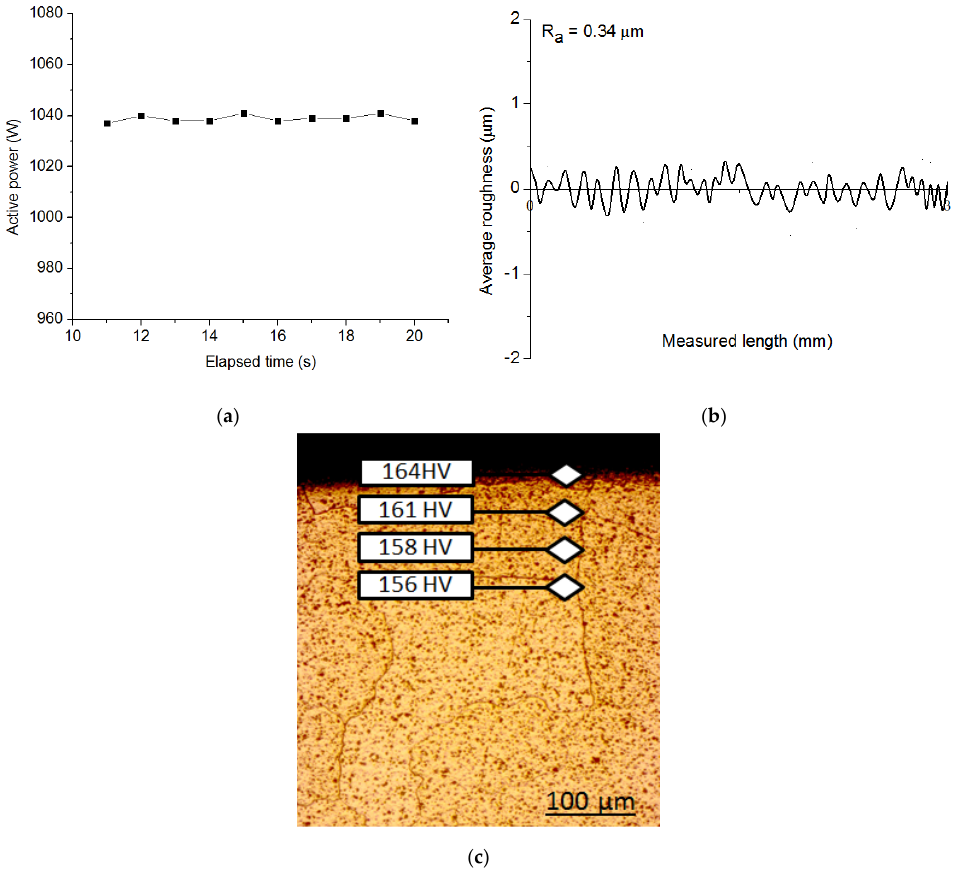
Figure 4. Representative values of the technical performances at the experimental No. 13: ( a ) Power consumed, ( b ) average roughness, ( c ) Vicker hardness.